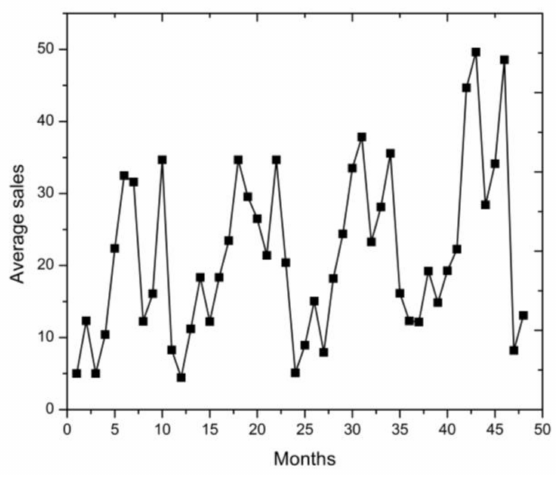
Figure 7. Monthly average sales data of Slovenian company. Adapted from